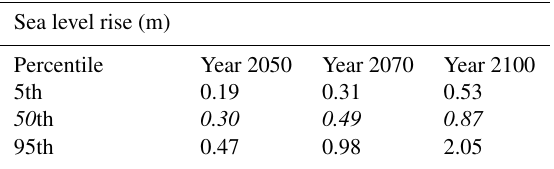
Table 5. Overview of the considered SLR projections for the study area for the years 2050, 2070 and 2100, according to Vousdoukas et al. (2018a). The baseline values are